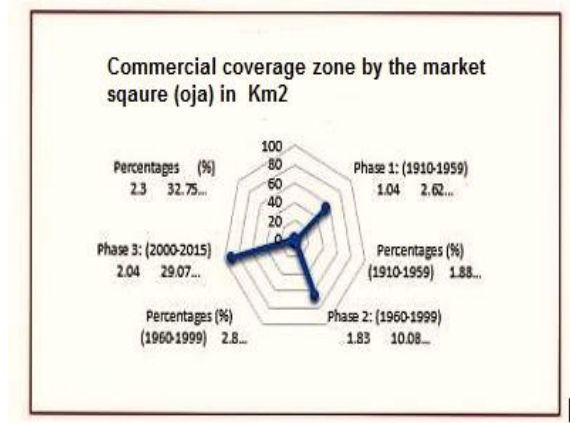
Figure 8. Land use coverage by the market square (oja) in Km 2